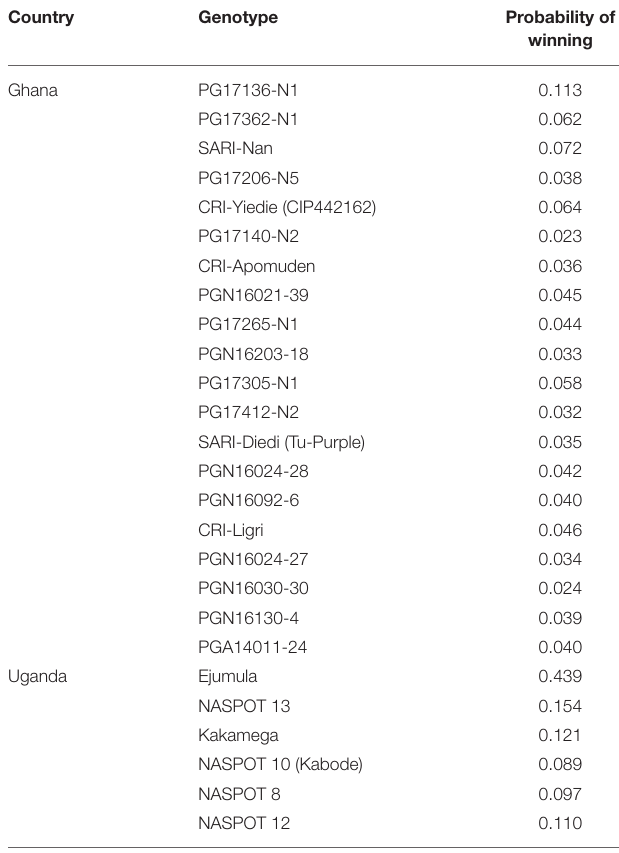
TABLE 7 | Expected probability of winning (average of all nodes in the Plackett-Luce Tree) across the nodes in the Plackett-Luce Trees for Ghana and Uganda.